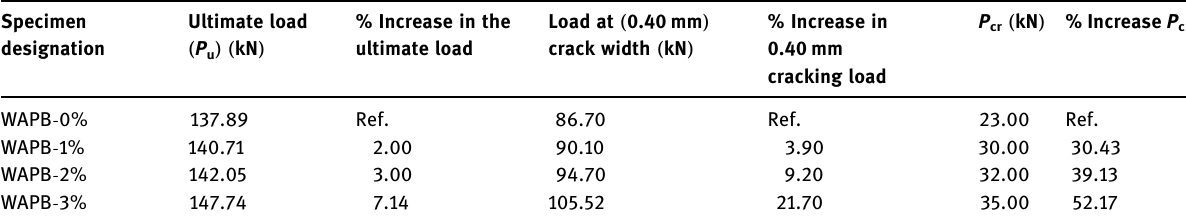
Table 11: The specimens ’ cracking and ultimate